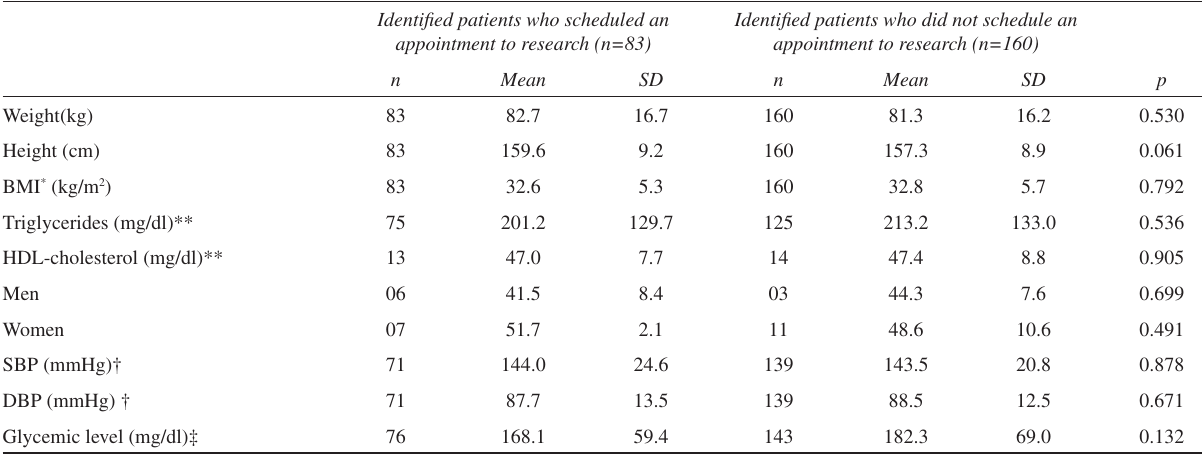
Table 2 - Clinical characteristics of 243 identified patients with evidence of metabolic syndrome, according to medical records